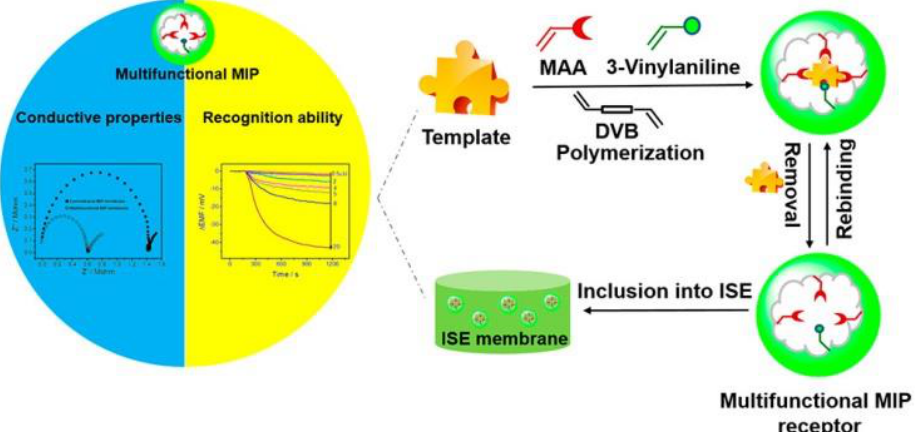
Figure 4. Schematic illustration of the MIP-based ISE sensor for neutral bisphenol detection using MIP for recognition on the ISE surface and charged ions as potential signals. Adapted with permission from Ref. [66] . Copyright 2022, American Chemical Society.